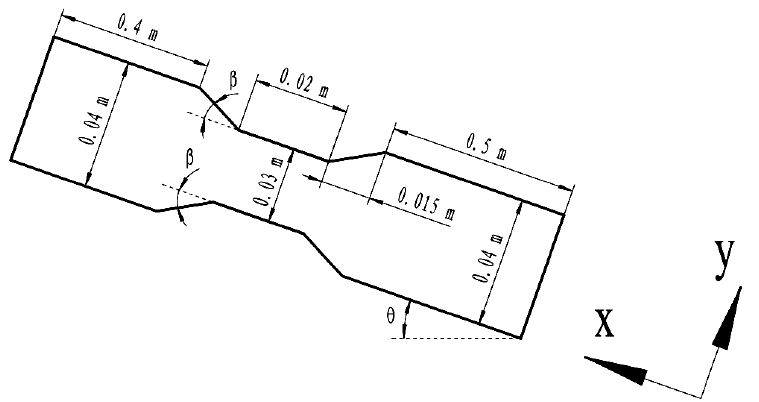
Figure 7. The gradually expanding inclined pipe [38]. ( β is the expansion angle, θ is the inclination angle.)